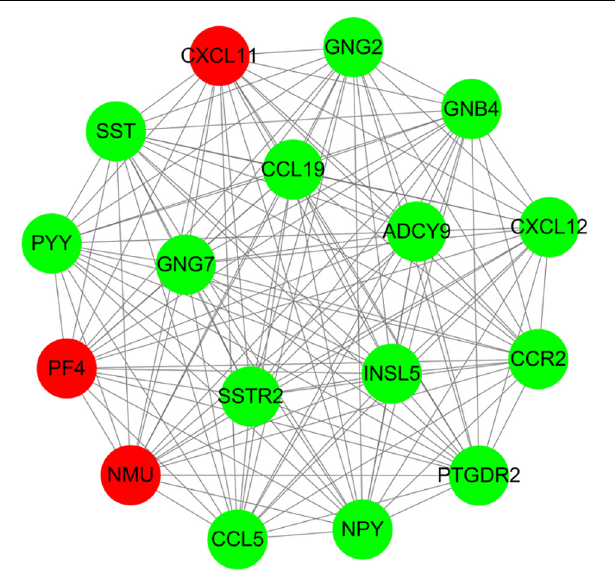
FIGURE 3 | A sub-network module with the highest score in PPI network conducted based on 514 DEGs between CRA and normal tissues. Red nodes and green nodes indicate upregulated and downregulated genes, respectively. PPI, protein–protein interaction; DEGs, differentially expressed genes; CRA, colorectal